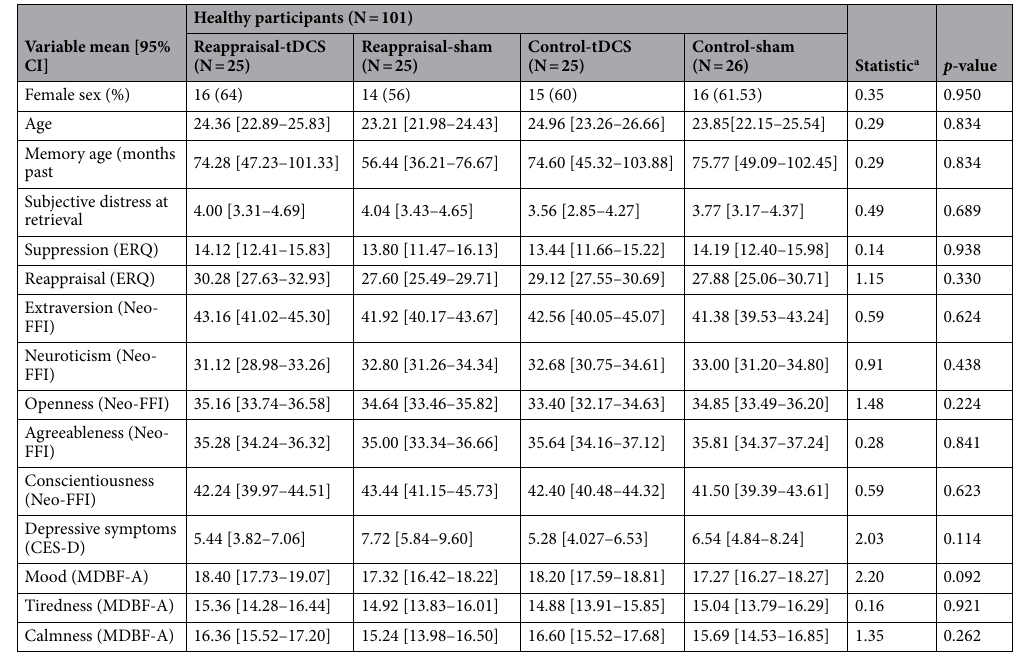
Table 1. Demographic, personality and clinical variables and tests for group differences. ERQ Emotion Regulation Questionnaire; NEO-FFI NEO-Five Factor Inventory; ADS-K German version of the short form of the Center for Epidemiologic Studies-Depression Scale, MDBF-A Multidimensional State Questionnaire Version A. a Χ 2 -tests for categorical data, ANOVA F -test for continuous